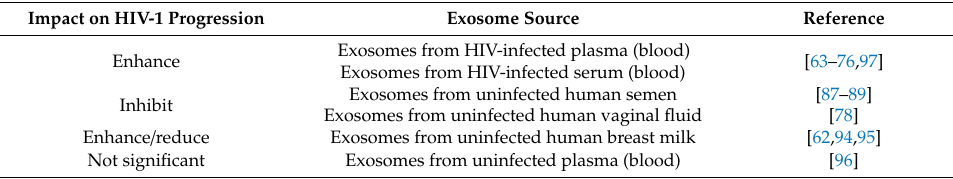
Table 1. List of exosomes shown to modulate HIV infection / transmission / disease